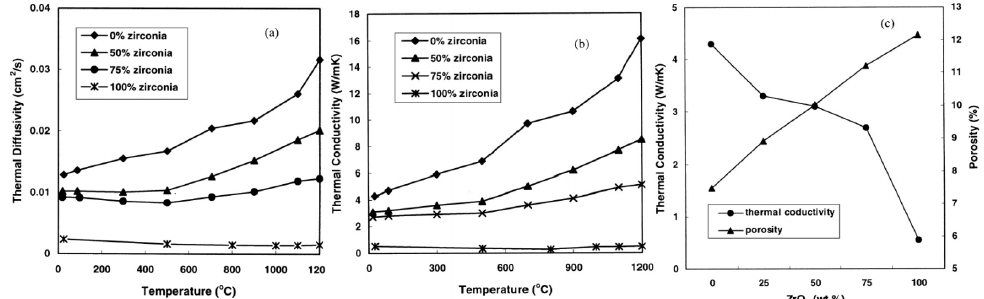
Figure 12. The purposes of the FGC mechanism: ( a ) thermal diffusivity, ( b ) thermal conductivity, and ( c ) the correlation between porosity and thermal conductivity in atmospheric temperature [48].